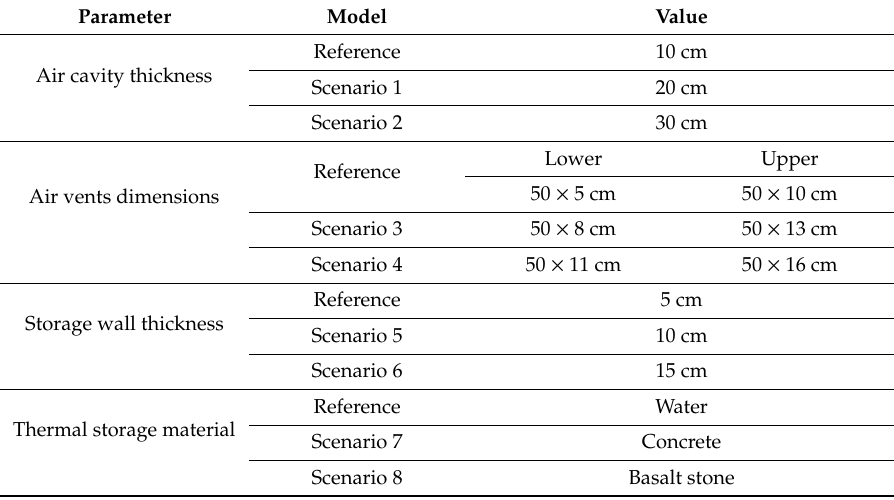
Table 3. Overview of evaluated parameters, models’ identifications, and used values.